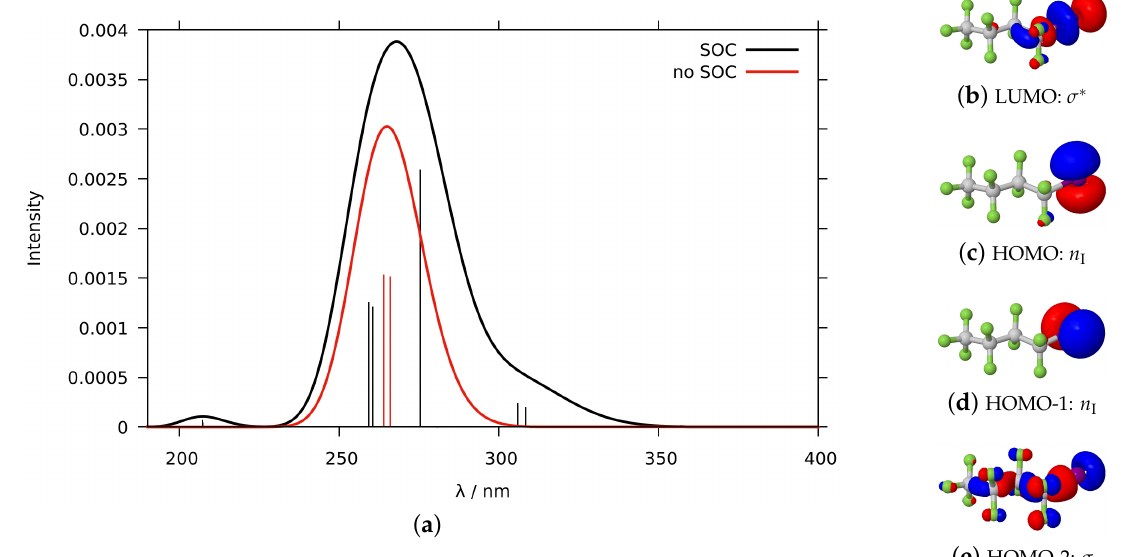
Figure 2. Calculated first absorption band of C 4 F 9 I (red: no spin–orbit coupling, only singlet transitions, black: including spin–orbit coupling, singlet as well as triplet transitions) and molecular orbitals involved in the transitions. The spectral envelope was obtained by broadening the line spectrum by Gaussians with standard deviation σ = 1500 cm − 1 . HOMO denotes the highest occupied molecular orbital, LUMO the lowest unoccupied molecular